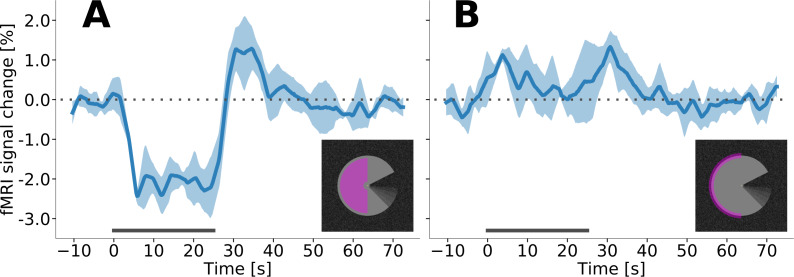
Event-related fMRI timecourses from an additional run with longer stimulus blocks, for V1 in the right hemisphere.In order to further investigate the temporal dynamics of the stimulus-evoked response, we acquired and additional run during which the motion induction stimulus was presented with longer block durations (in a subset of subjects, n = 5). Stimulus duration was 25 s, with rest blocks of 50 s. (A) The region of interest that corresponds to the stimulus centre shows a sustained, negative response that resembles the ‘canonical’ haemodynamic response function. (B) The response to the stimulus edge is transient and positive.